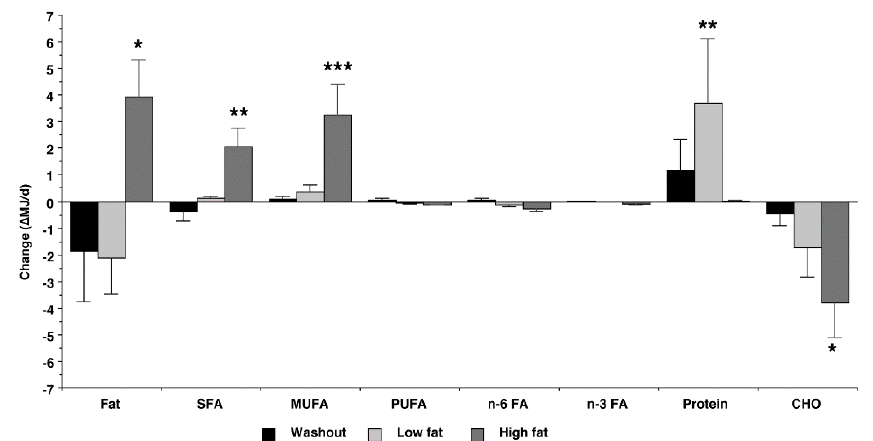
Figure 3. Absolute change (final – entry) in %MJ/d during consumption of ground beef patties initially containing 6 g fat/patty (Low fat) and 27 g fat/patty (High fat). Fat, total fat; SFA, saturated fat; MUFA, monounsaturated fat; PUFA, polyunsaturated fat; CHO, carbohydrate. Bars are means ( n = 25) with pooled SEM attached. Change statistically different from 0, * p ≤ 0.05; ** p ≤ 0.01; *** p ≤ 0.001. Table 3. Intakes of major nutrients for men at entry, following washout, and during consumption of ground beef patties initially containing 6 g fat/patty (Low-fat) or 27 g fat/patty (High-fat) 1 .